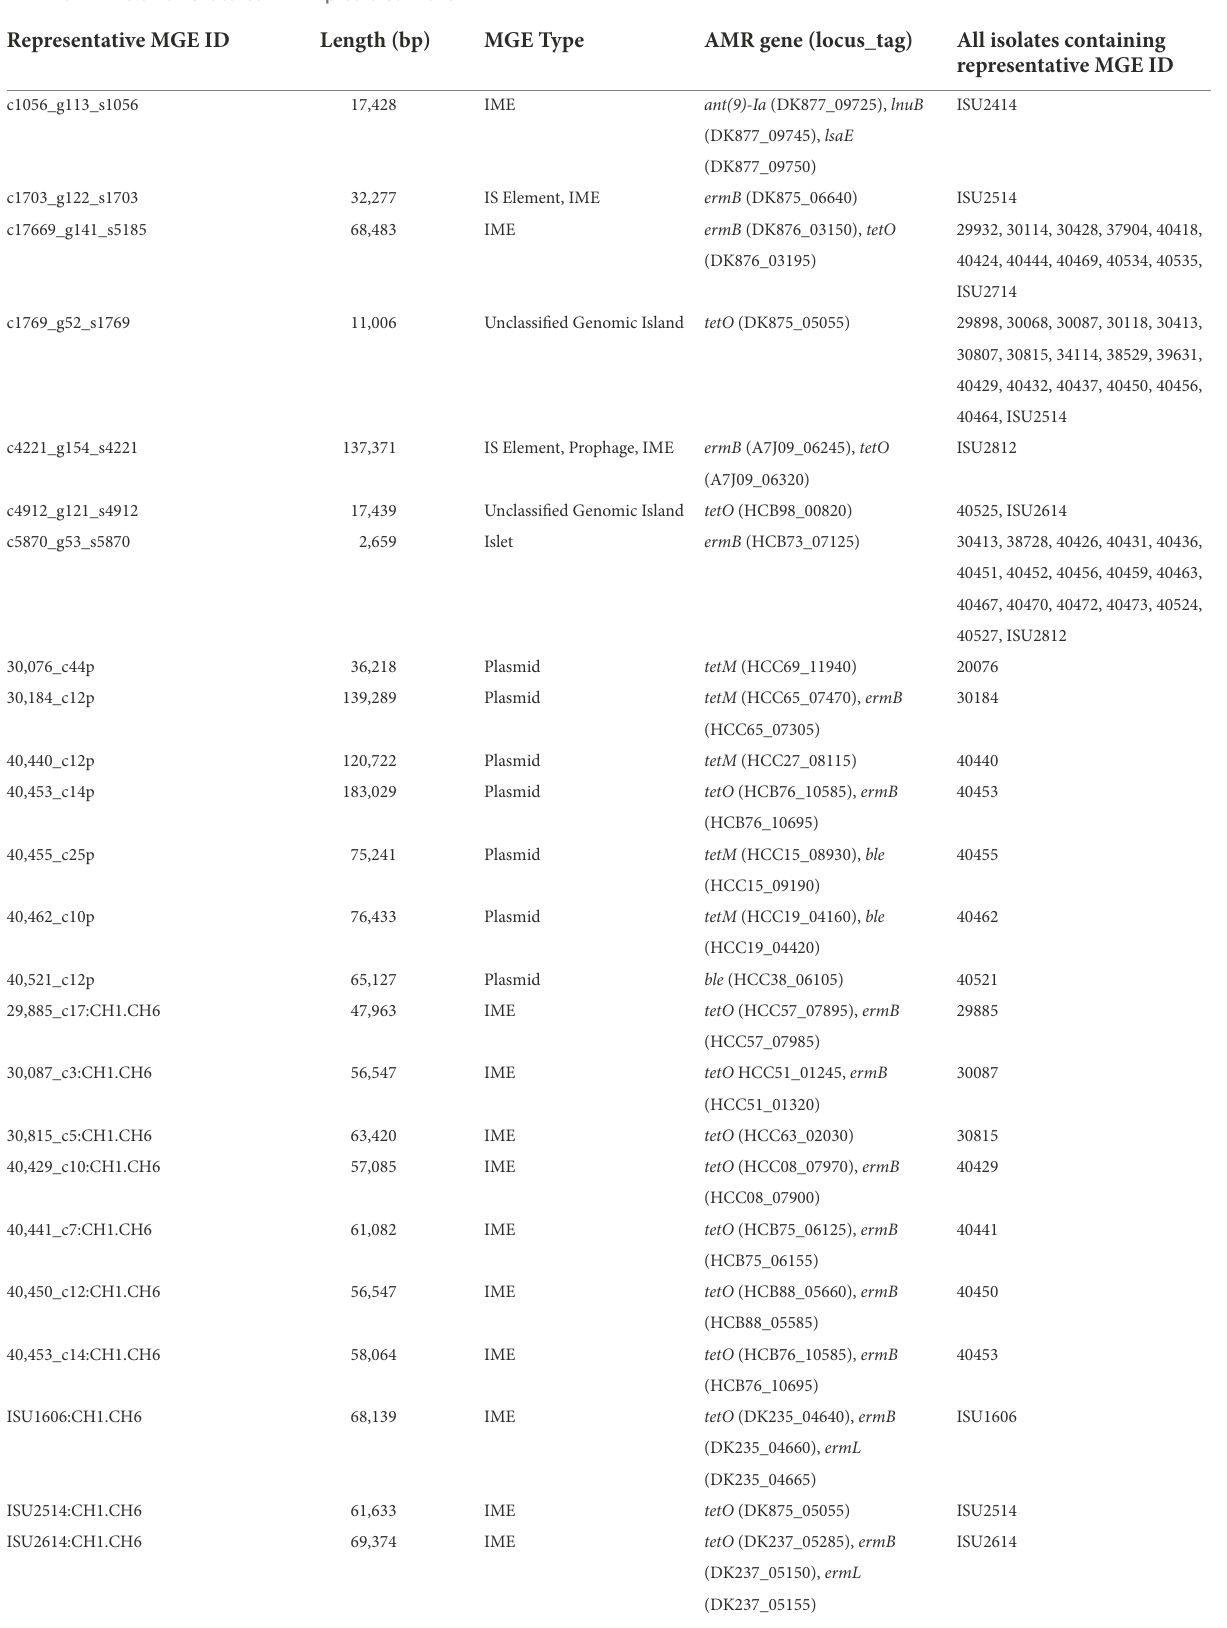
TABLE 5 AMR elements located within predicted